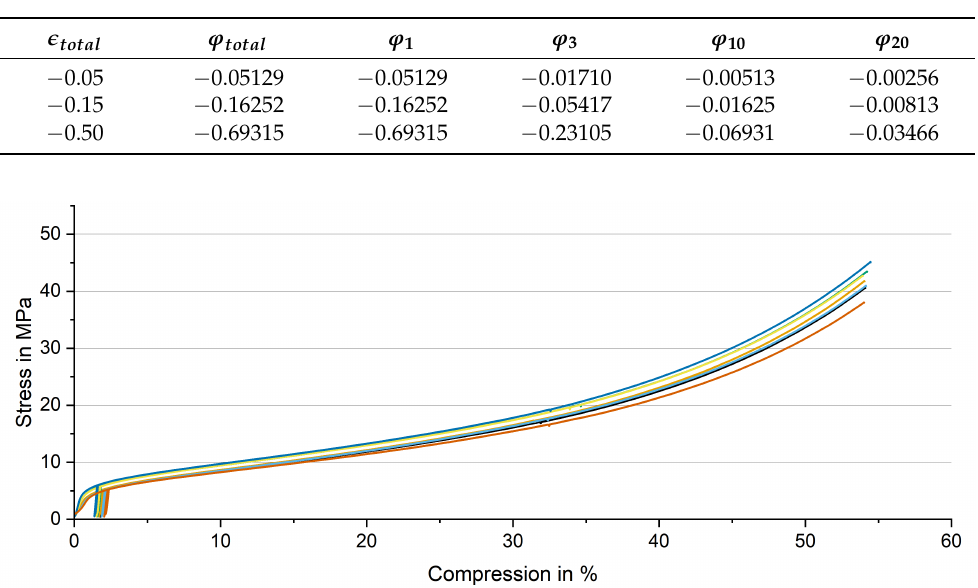
Table A1. Total degree of deformation ϕ total and degree of deformation for each pass of samples with different amounts of total rolling passes 1, 3, 10 and 20.